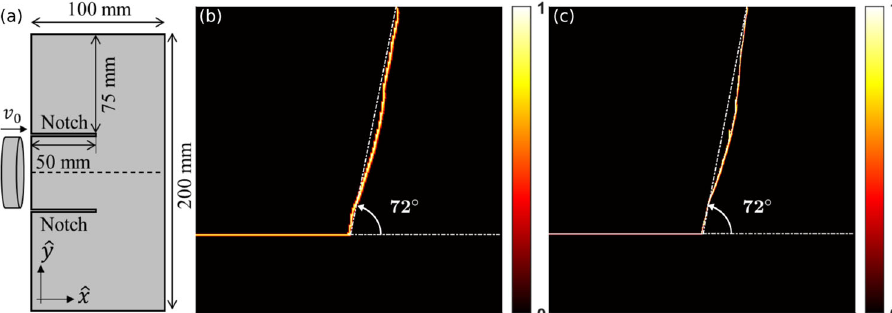
Fig. 1 Simulation of the Kalthoff – Winkler experiment. a Schematic of the edge-cracked plate under impact loading known as the Kalthoff – Winkler experiment 45 . Crack patterns simulated using the VO damage model are presented for two different mesh con fi gurations b h = 0.5 mm and c h = 0.25 mm. The average angle of the crack front in both b and c is obtained as 72 ∘ indicating an excellent match with the experimental result.